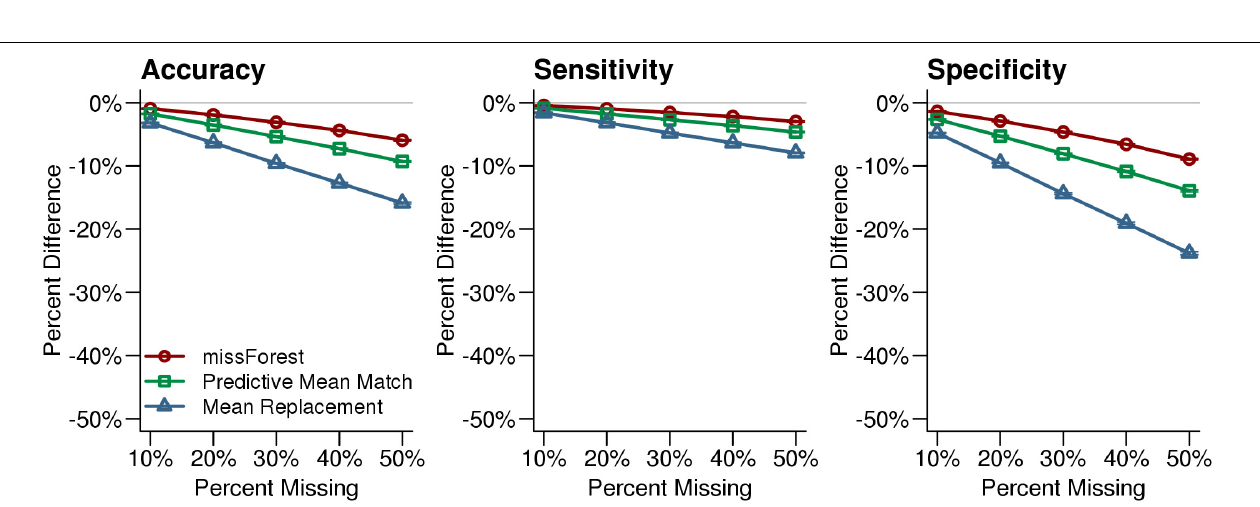
FIGURE 3 | Reading profile classification accuracy for the imputed synthetic datasets. Reading profile classifications based on synthetic datasets with no missing data were compared to classifications that were performed after imputing missing values with missForest, Predictive Mean Matching, and Mean Replacement. The missForest imputation (red line) resulted in the most accurate classifications. The x -axis in each plot indicates the simulated percent missingness, while the y -axis indicates the reduction in classification accuracy, sensitivity, and specificity for the imputed datasets compared with the complete synthetic dataset. Each point shows the average with SEM error bars calculated over 1,000